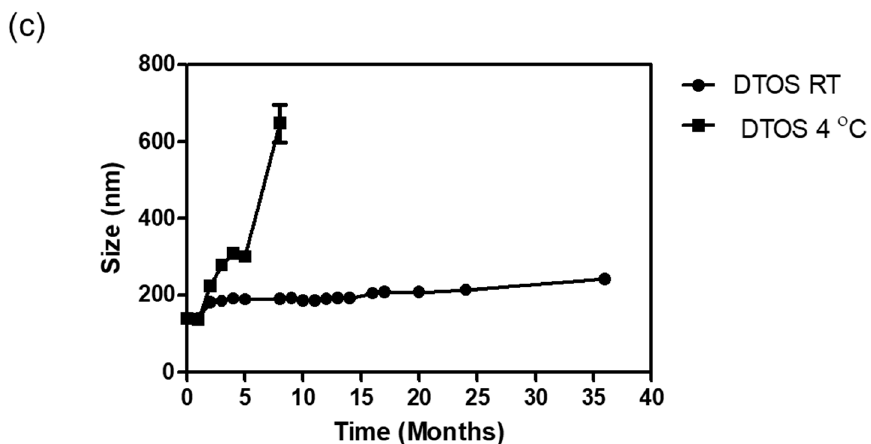
Figure 5. The stability of the DTOS emulsion. ( a ) Mean DLS diameter of the DTOS emulsion at a defined time. ( b ) Mean polydispersity index of the DTOS emulsion at a defined time. ( c ) DTOS emulsion stability under different temperatures at a specified time. The data are presented as the mean value ± standard deviation of triplicate experiments.